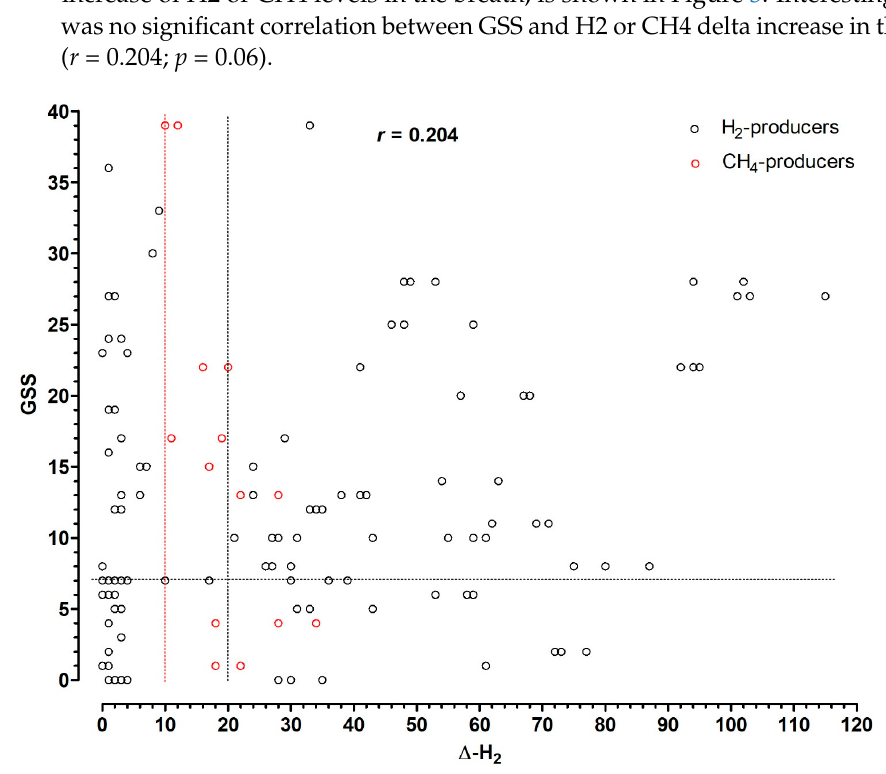
Figure 3. Global symptom score (GSS) distribution according to lactose hydrogen breah test (HBT) results, expressed as delta increase over baseline of H 2 or CH 4 levels in the breath after 25 g lactose load. The horizontal dotted line indicates the cut-off of clinically relevant GSS. The vertical dotted red and black lines indicate the cut-offs used to diagnose lactose malabsorption for CH 4 and H 2 , respectively. There was no significant correlation between GSS and H 2 or CH 4 delta increase in the breath ( r = 0.204; p = 0.06). (7) After the placebo challenge, 45 out of 60 (75%) LM patients with GSS > 7 at LQ, did not complain of clinically relevant symptoms, thus fulfilling the criteria for the diagnosis of lactose intolerance, according to NIH Consensus on Lactose In- tolerance and Health (Figure 4).